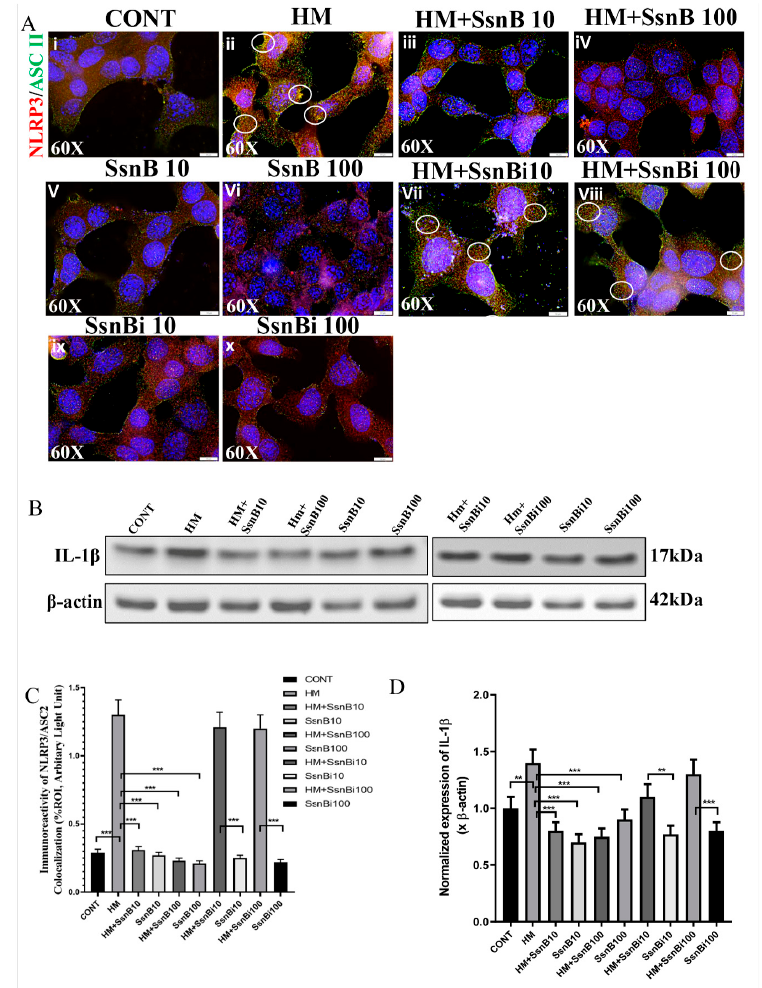
Figure 5. SsnB attenuates HMGB1 induced NLRP3 inflammasome activation in primary mouse intestinal epithelial cells. Mouse primary intestinal epithelial cells were treated with HMGB1 (HM), HMGB1 with SsnB at 10 µ g / mL (HM + SsnB10) and 100 µ g / mL (HM + SsnB100) concentrations and only SsnB at 10 µ g / mL (SsnB10) and 100 µ g / mL (SsnB100) concentrations. To confirm the role of SsnB in attenuating HMGB1 induced NLRP3 activation, the cells were further treated with inactivated or pseudo-SsnB along with HMGB1 at 10 µ g / mL (HM + SsnBi10) and 100 µ g / mL (HM + SsniB100) concentrations. Inactivated SsnB at the two concentrations (SsnBi10 and SsnBi100, respectively) were used as controls to compare with HM + SsnBi10 and HM + SsniB100. The colocalization study of